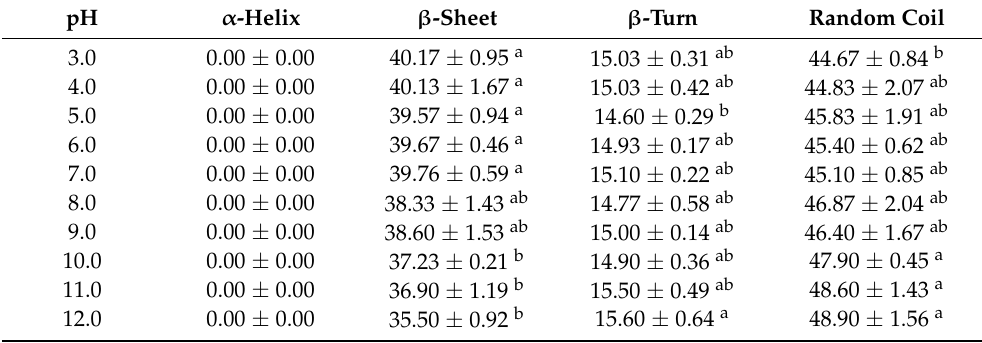
Table 2. Secondary structures of